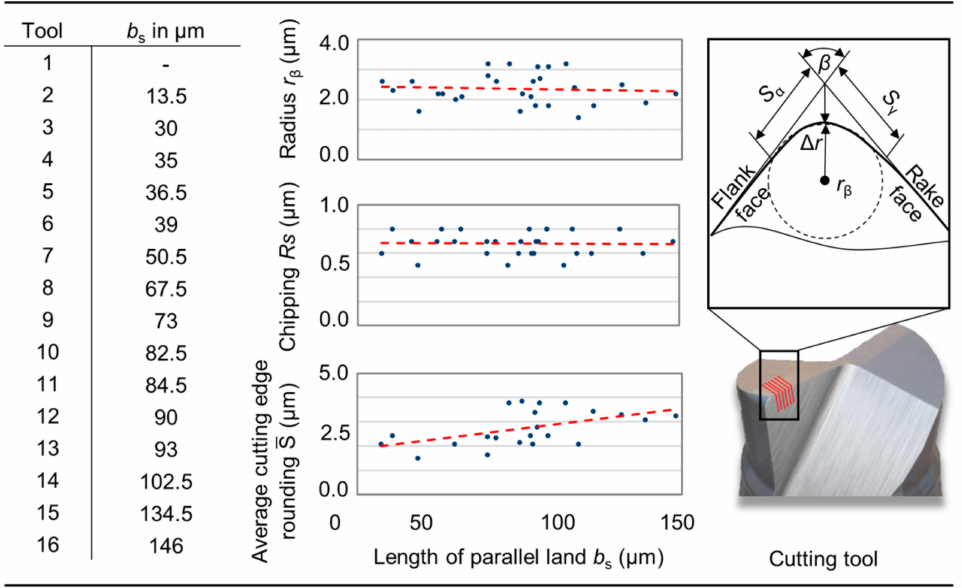
Figure 4. Specification of prepared tools for cutting